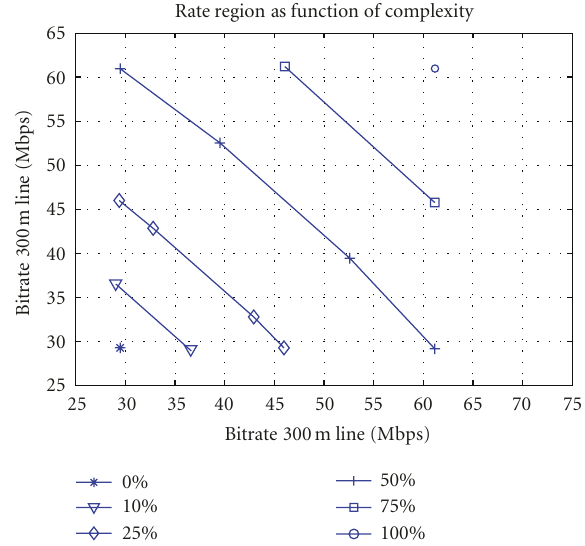
Figure 4: Rate regions for various crosstalk cancellation complexi-